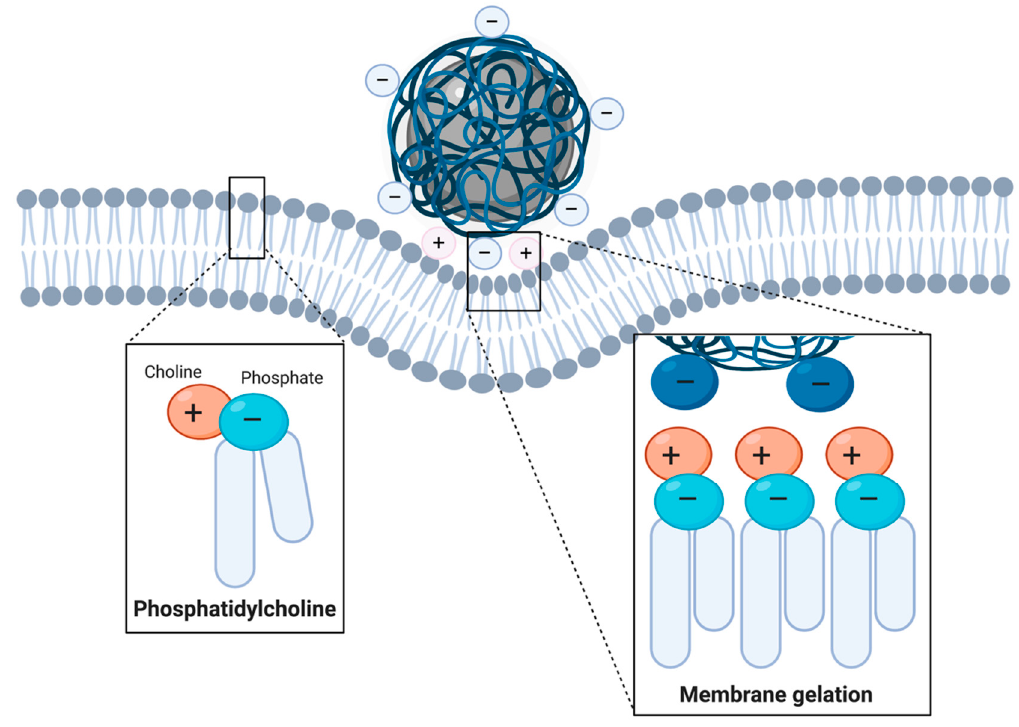
Figure 3. Local membrane gelation induced by ANPs in phosphatidylcholine-rich membrane microdomains. (Created with BioRender.com).